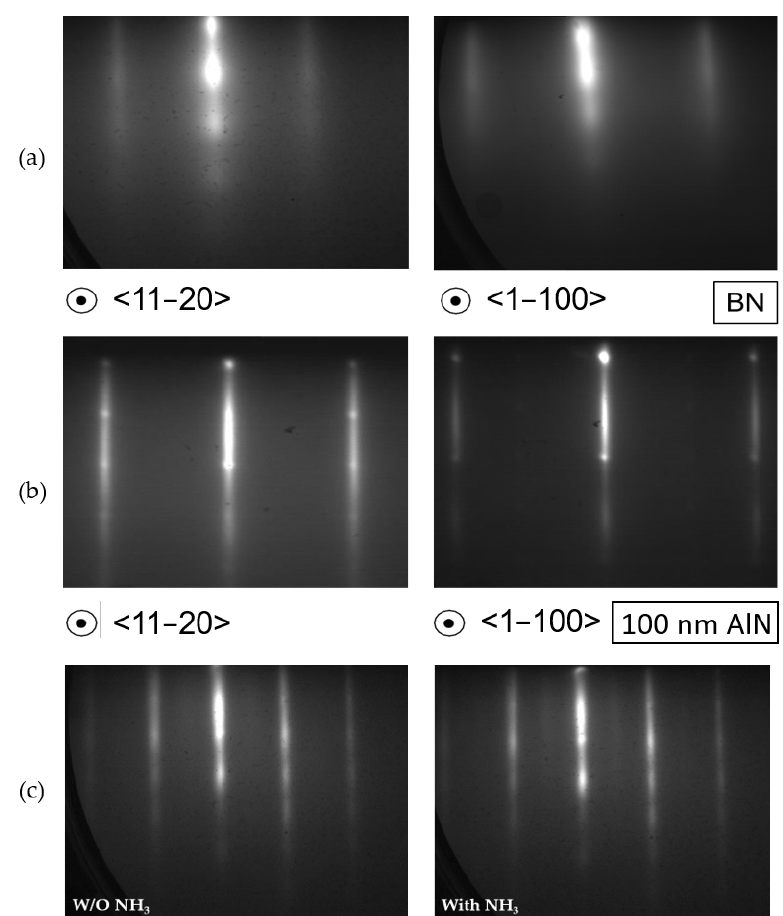
1 1 −2 0 and 1 −1 〈 〉 〈